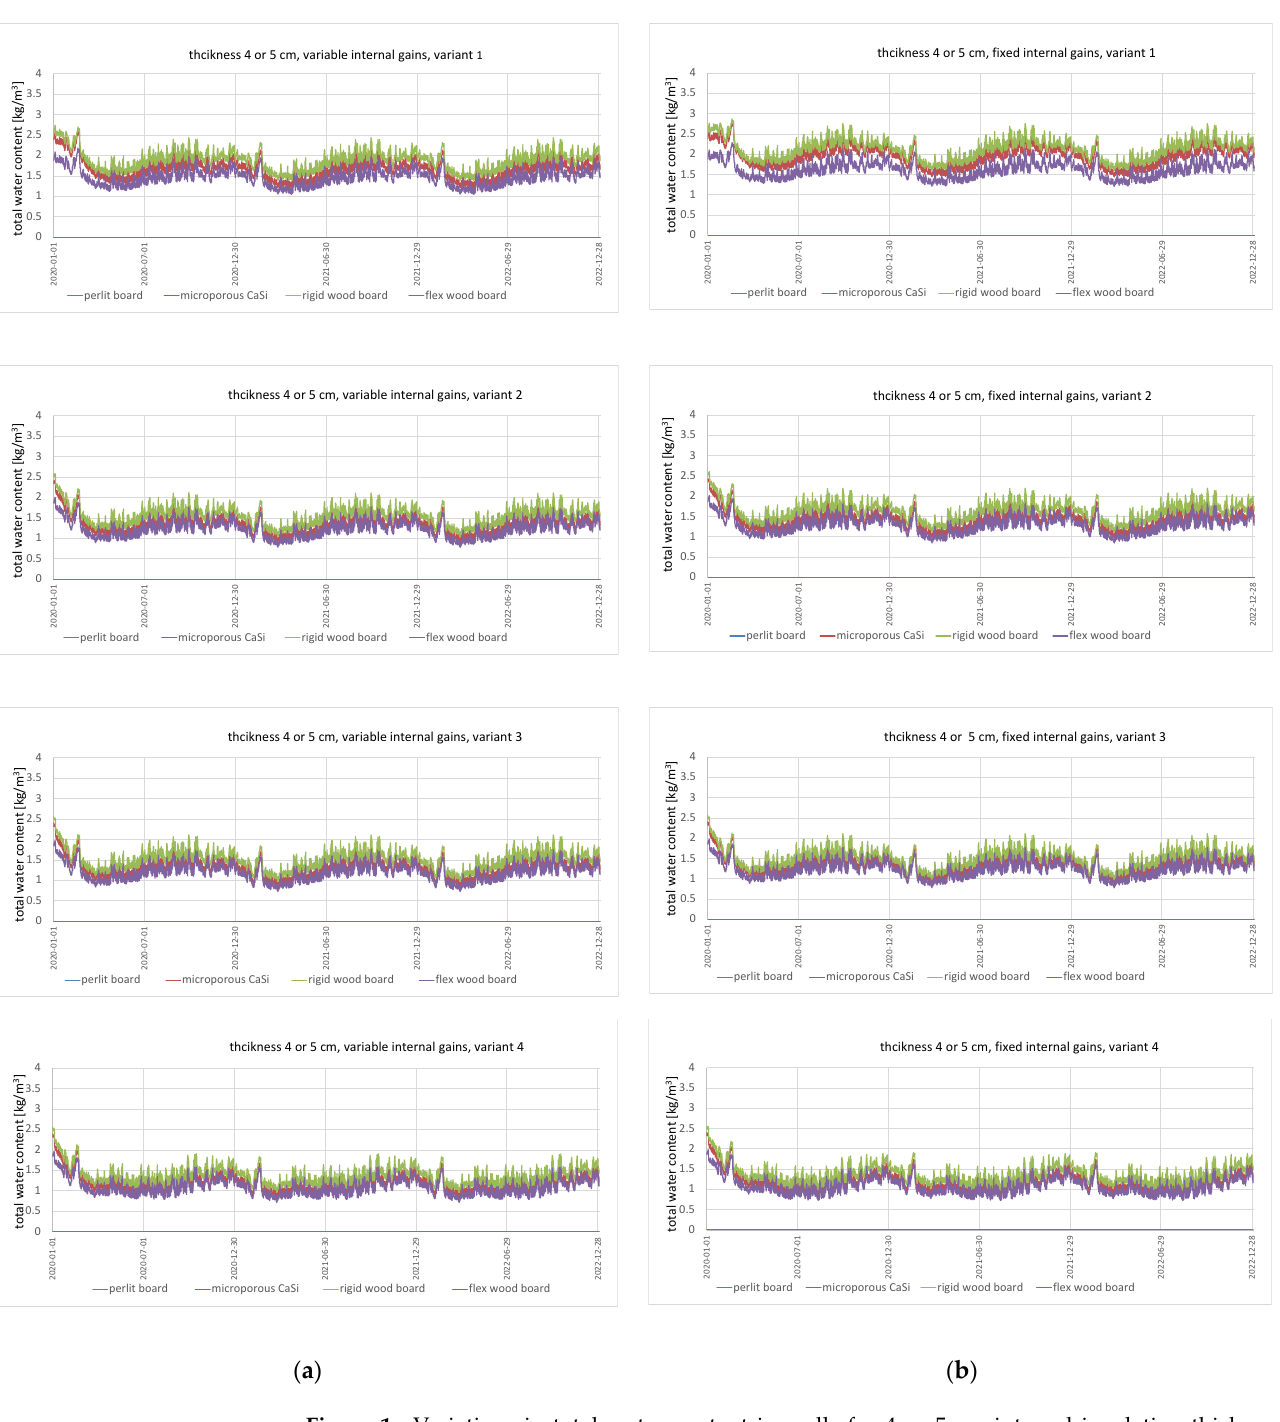
Figure 1. Variations in total water content in walls for 4 or 5 cm internal insulation thickness: ( a ) variable internal gains; ( b ) fixed internal gains.